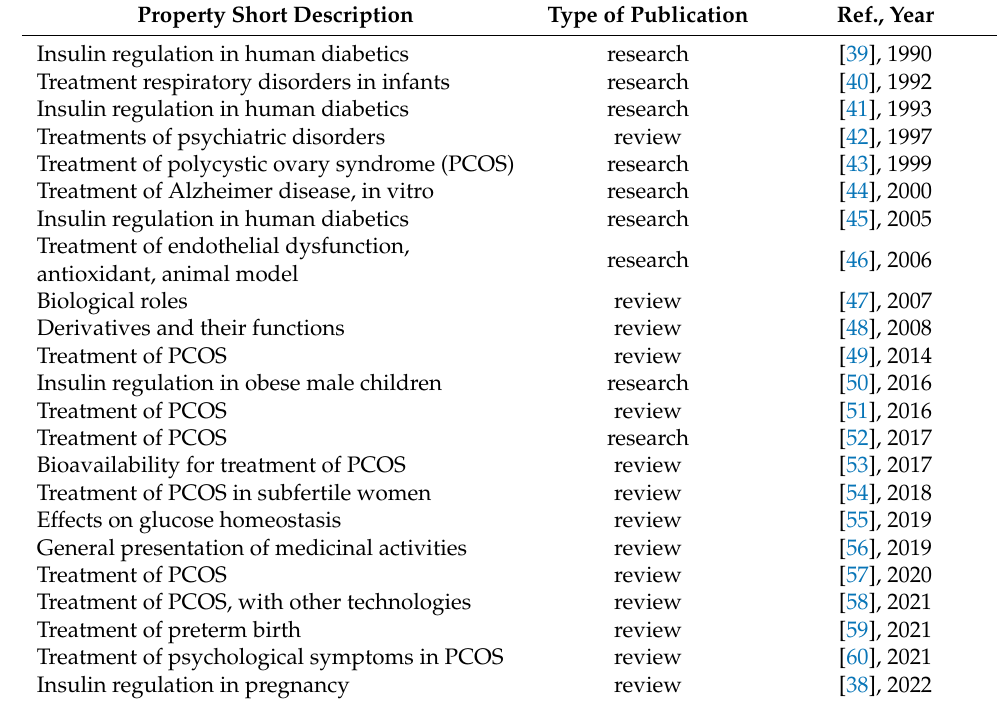
Figure 6. Structures of naturally occurring inositols. Table 4. Selected publications of insulin regulation and women fertility disorders treatment of